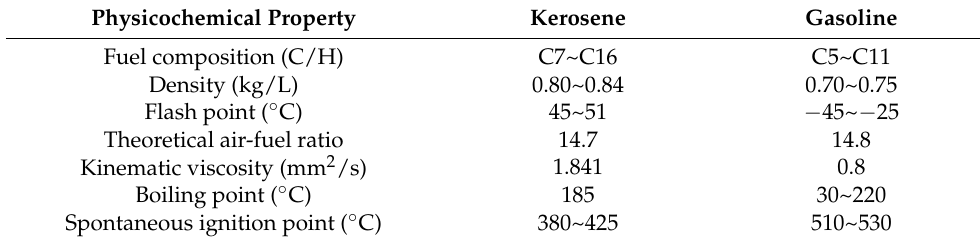
Table 2. Comparison of the properties of kerosene and